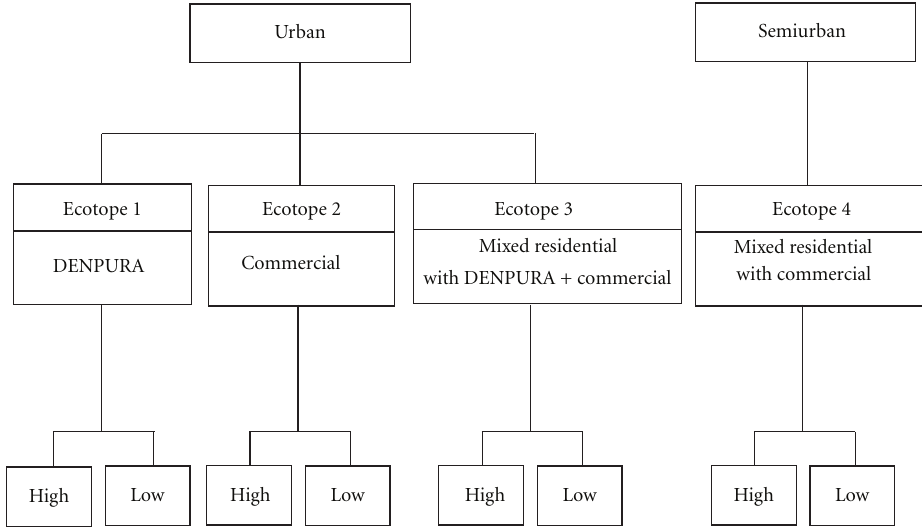
Figure 2: Diagram showing selection criteria for the 12 blocks: (1) degree of urbanization and (2) intensity of dengue transmission. Abbreviation: DENPURA—densely populated urban residential